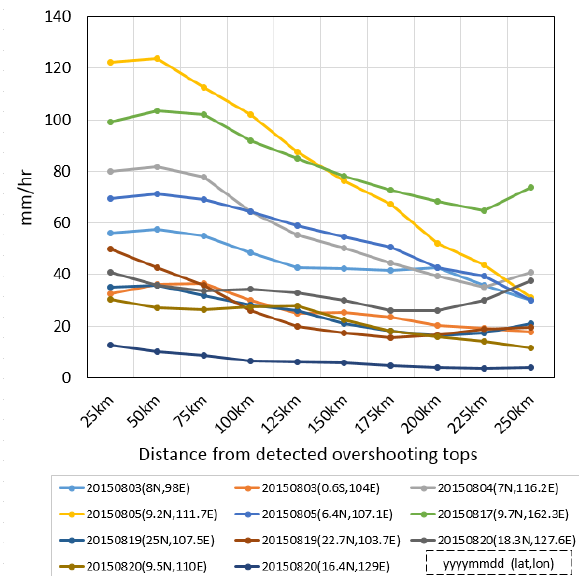
Figure 2. Precipitation distributions (mm/hr) at each radial distance from OTs based on TRMM 3b42.V7(25km,